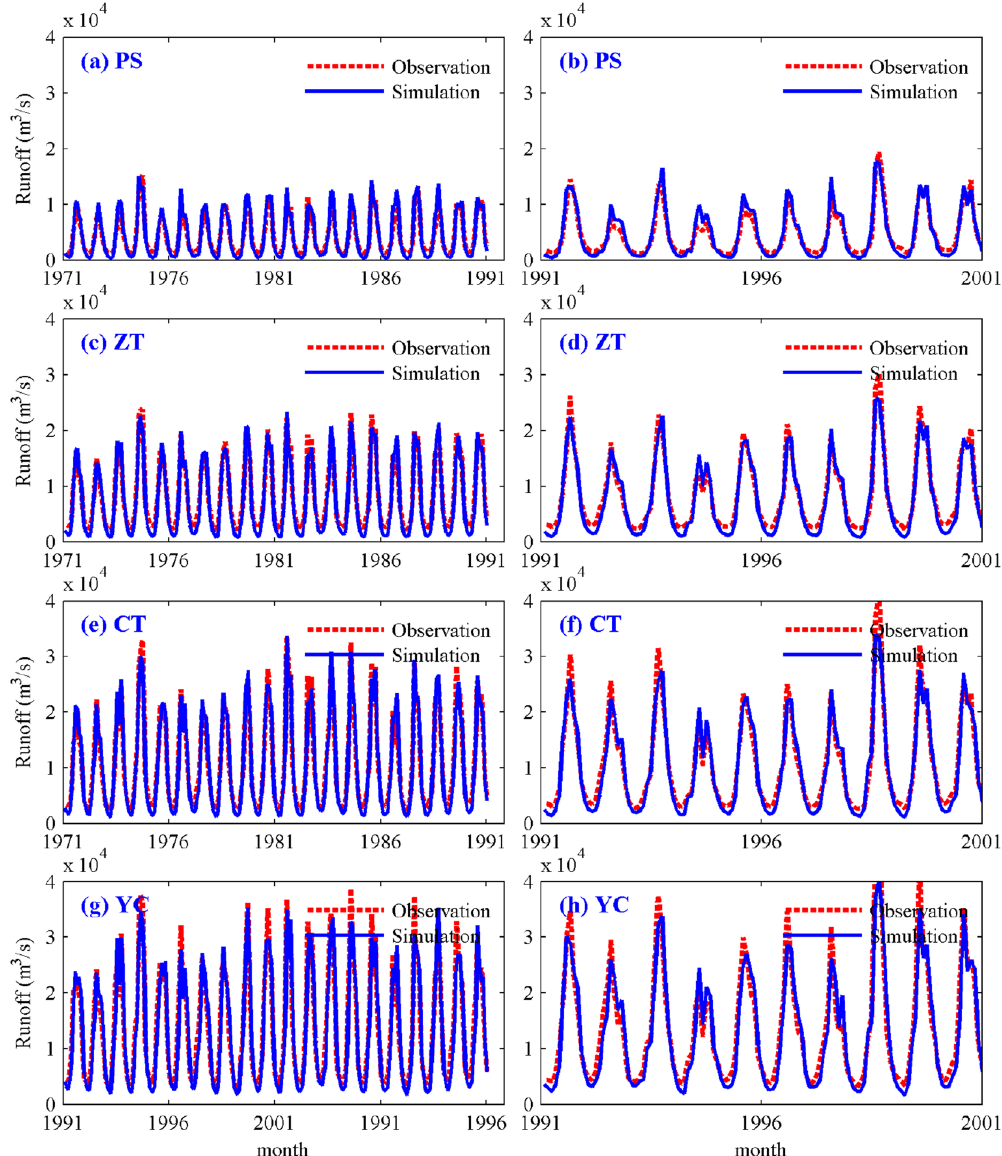
Figure 5. Comparisons of simulated and observed monthly mean runoff processes during calibration ( a,c,e,g ) and verification ( b,d,f,h ) periods. The figure was generated by MATLAB2019a (https:// www. mathw orks. com/).